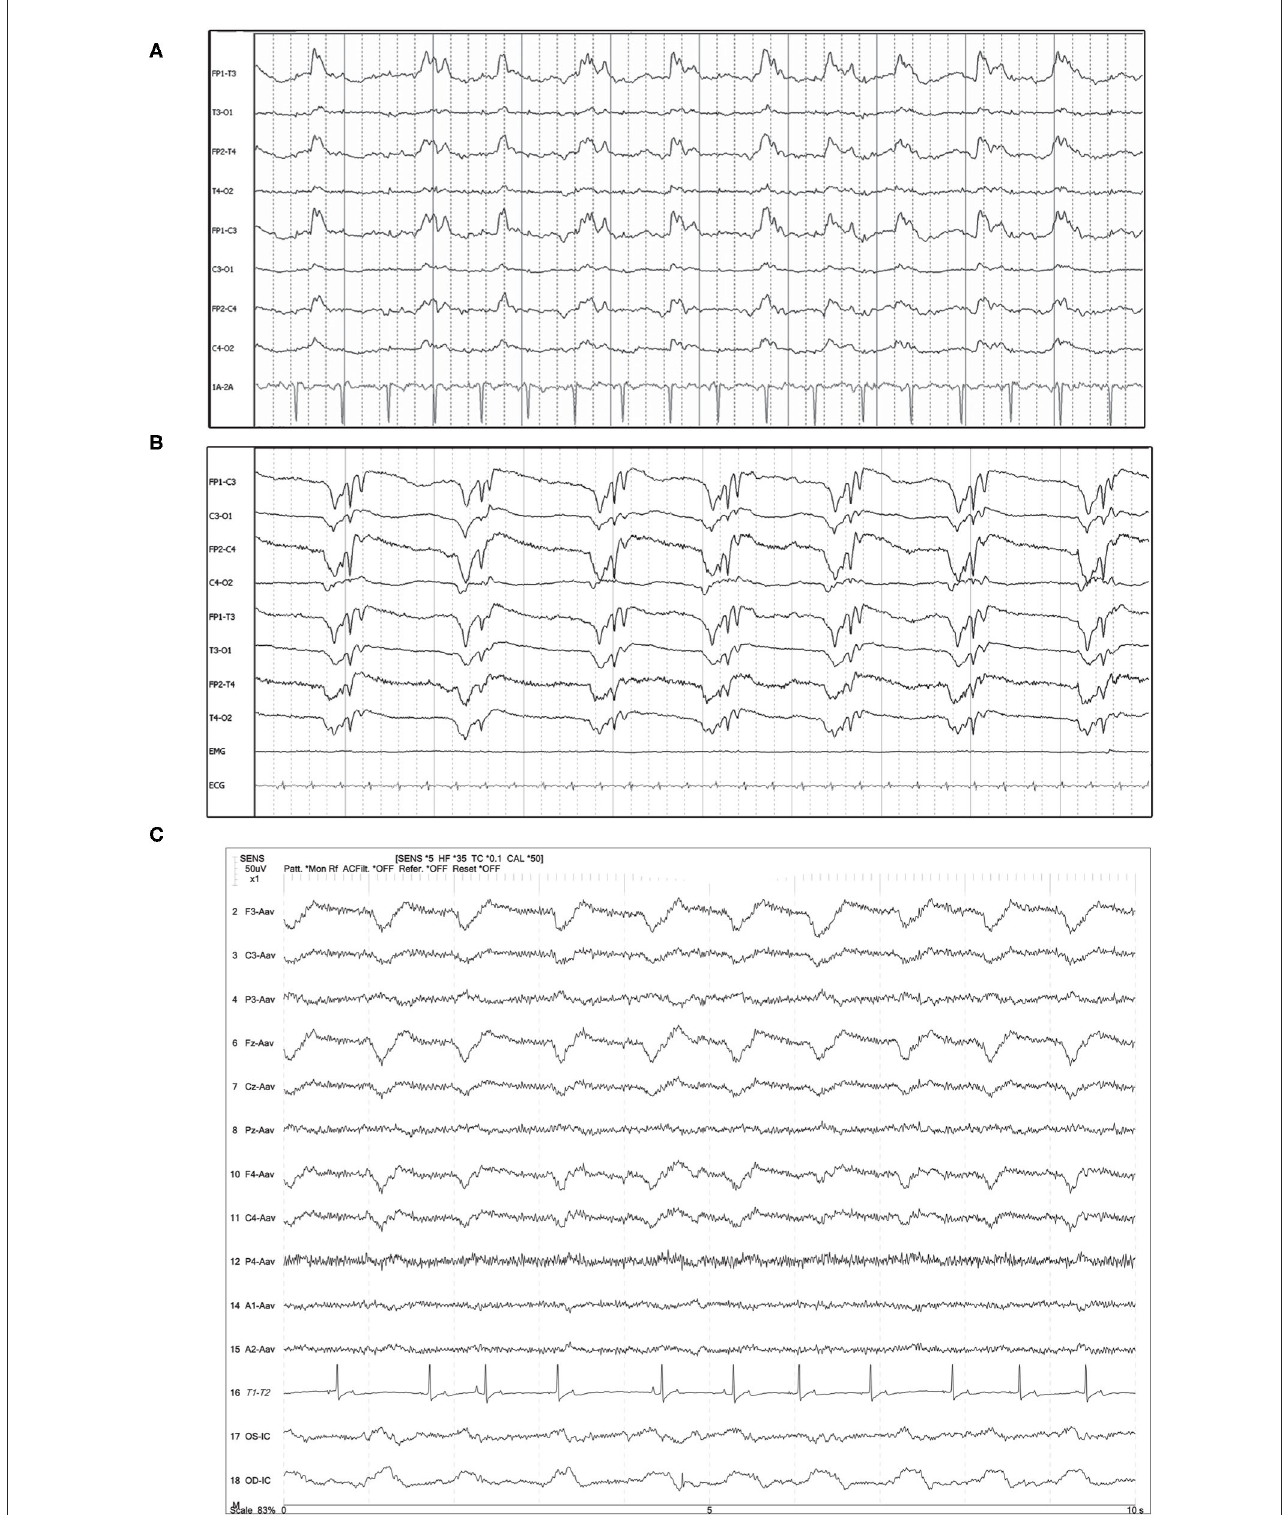
FIGURE1 Three examples of generalized periodic discharges (GPDs). PDs are noted predominantly frontal and in both hemispheres in each case. (A) Ten year old mixed breed dog with several year history of seizures and recent cluster seizures. Polyphasic GPDs, synchronous and bilateral, with slightly higher amplitude in the left hemisphere (Bipolar montage; HF 70Hz, sensitivity 5 uV/mm). (B) Four year old domestic longhair cat with otogenic bacterial encephalitis and seizures. Polyphasic GPDs (Bipolar montage; HF 70Hz, sensitivity 7 uV/mm). (C) Thirteen year old Bichon frise with MUO and recent cluster seizures (Referential montage; HF 35Hz, sensitivity 5 uV/mm). The amplitude of the discharge is slightly lower in F4 than F3 & Fz, although the timing of the PD is synchronous in the frontal leads. MUO, meningoencephalitis of unknown